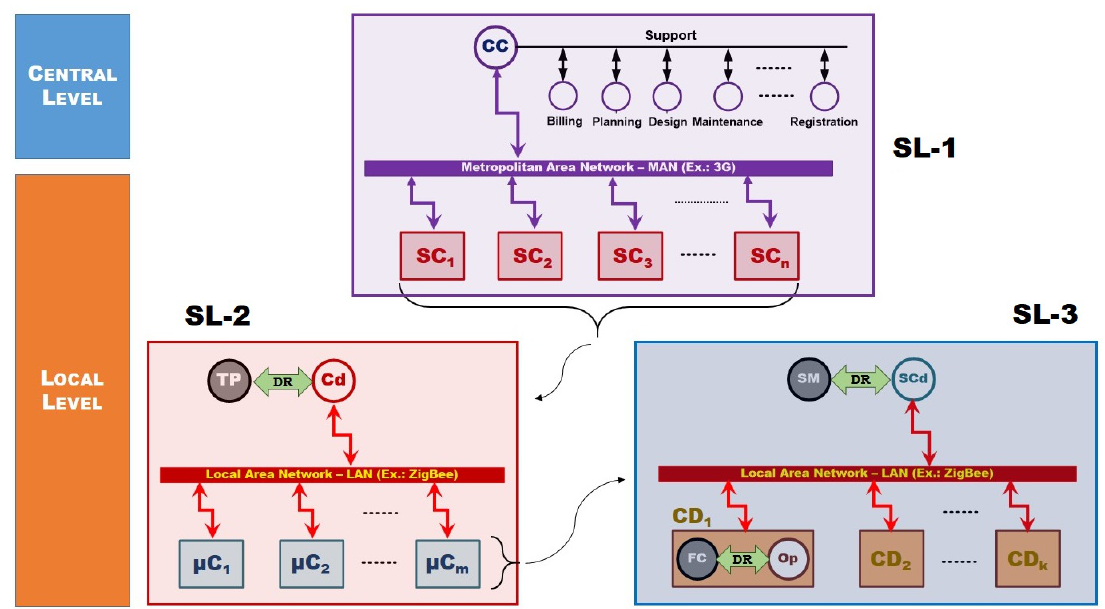
Figure 9. Description of the three-tiered hierarchical architecture of the SmartLVGrid model (Gomes,